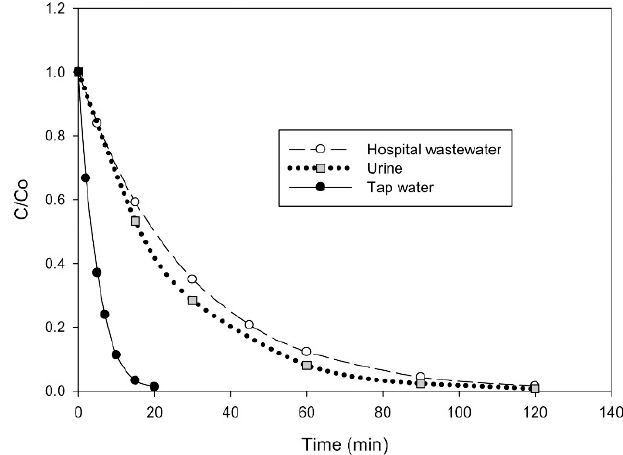
Figure 10. Degradation of piroxicam in different matrices. Experimental conditions: [Piroxicam] = 0.08 mM; [Na 2 SO 4 ] = 0.05 M; [Fe 2+ ] = 0.10 mM; I = 100 mA (4.17 mA cm − 2 ); V = 0.25 L; pH = 3.0 and room temperature. Reprinted with permission from ref. [92]. Copyright 2019 Elservier.